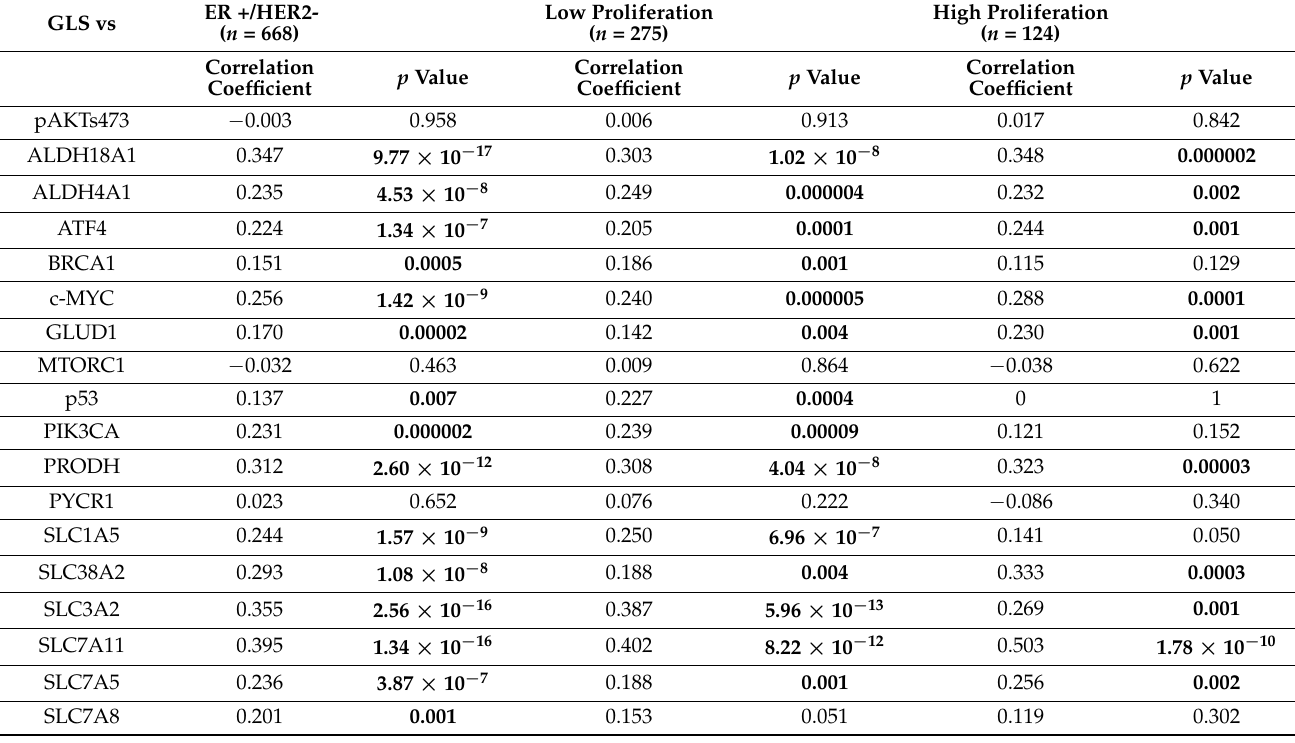
Table 3. Correlation of GLS protein expression with glutamine-metabolism-related proteins in invasive luminal breast cancer. GLS vs